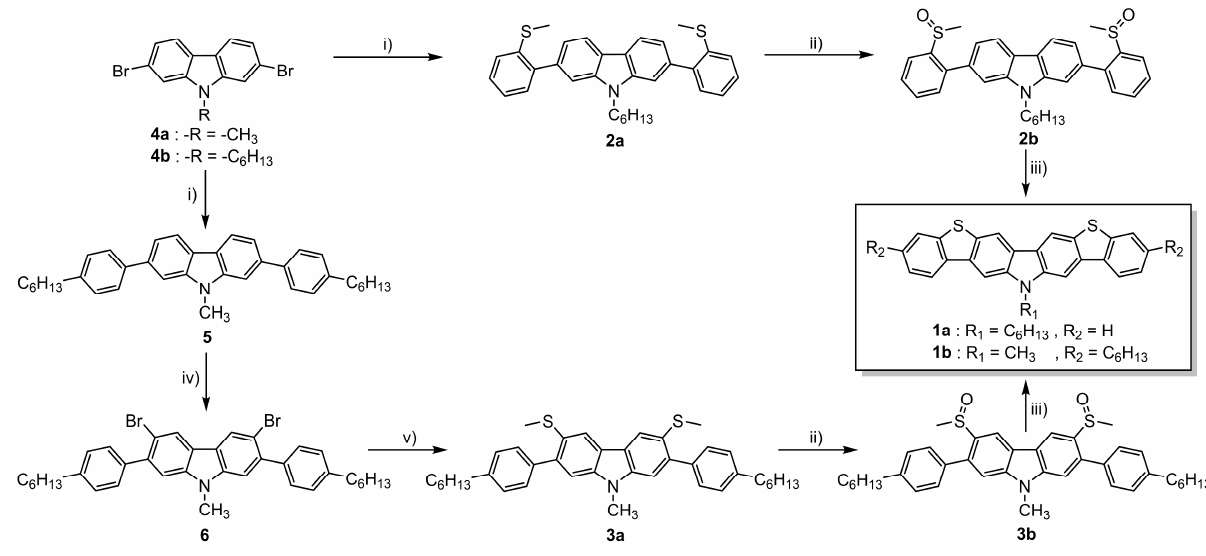
Figure 2. Synthetic routes followed to obtain the final compounds 1a – b . Reagents and conditions: (i) Boronic acid (4- hexylphenylboronic acid for 5 and 2-methylthiophenylboronic acid for 2a ), Pd(PPh 3 ) 4 , K 2 CO 3 in THF:H 2 O, reflux. (ii) H 2 O 2 in AcOH ( 2b ) or AcOH:CHCl 3 ( 3b ), RT. (iii) a. CF 3 SO 3 H, P 2 O 5 , RT; b. pyridine, reflux. (iv) NBS in AcOH:CHCl 3 , RT. (v) a. BuLi in THF, − 78 °C; b. CH 3 SSCH 3 , RT.